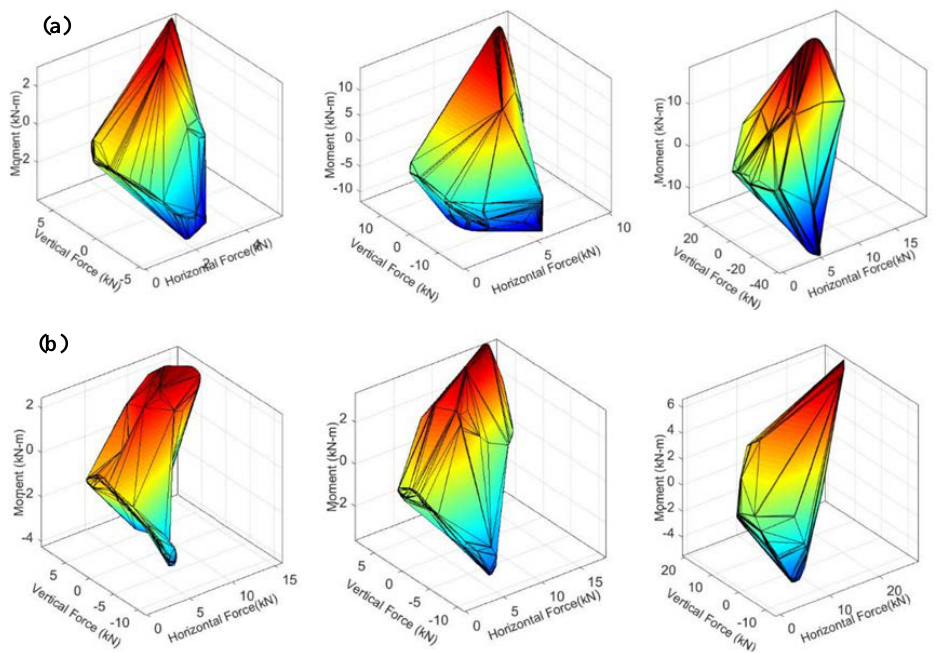
Figure 17. 3D demand diagrams of forces and moment for ( a ) solitary waves (top) with H = 0.42 m (left), H = 0.55 m (center) and H = 0.70 m (right), and ( b ) bores (bottom) with H = 1.0 m (left), H = 1.10 m (center) and H = 1.40 m (right).